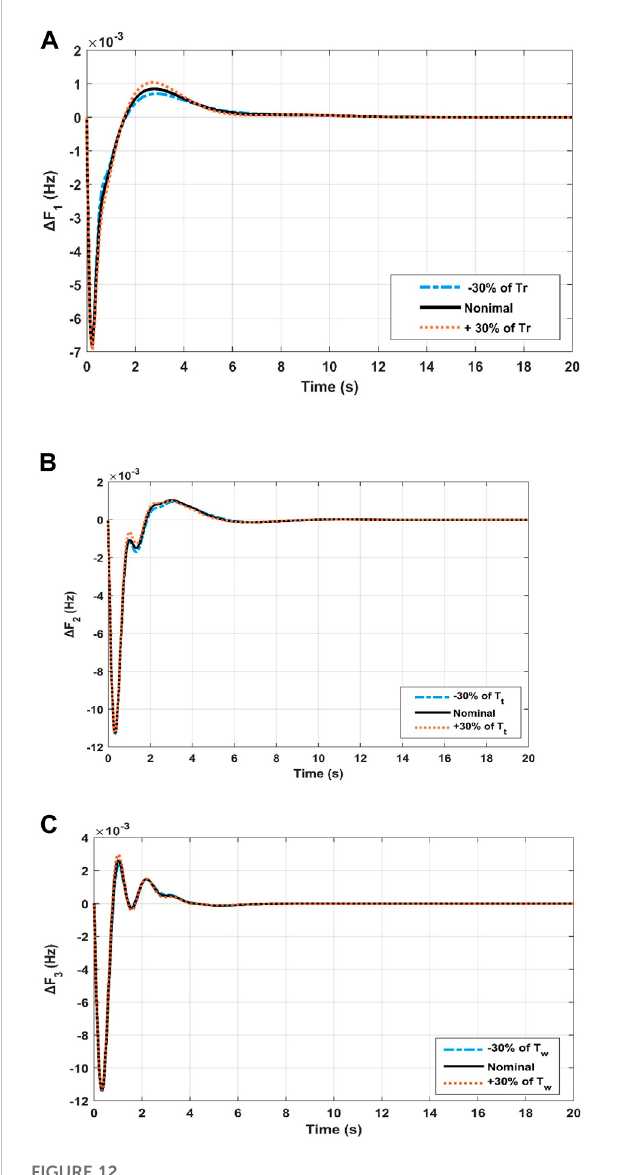
FIGURE 12 Sensitivity analysis for proposed FOA based MRPID controller. (A) Δ F Δ F Δ F 1 , (B) 2 , (C) 3 .